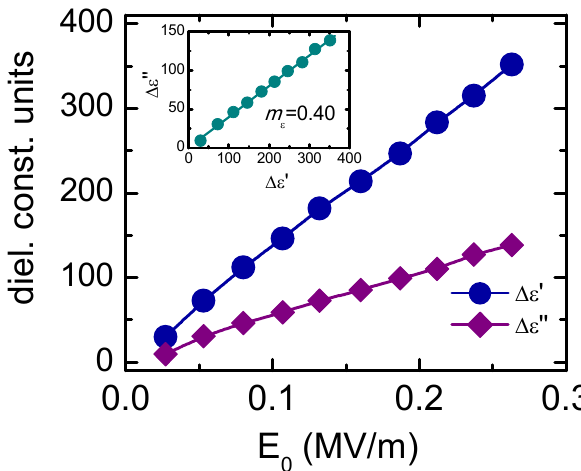
Figure 7. Increments of the real ( Δε′ ) and imaginary ( Δε″ ) parts of the relative permittivity for KNL ‐ NTS at room temperature. The inset shows the relation between Δε″ and Δε′ , and the ratio m ε = Δε″ / Δε′ is reported. Figure reprinted from reference [30] (Copyright IOP Publishing Ltd., 2009).